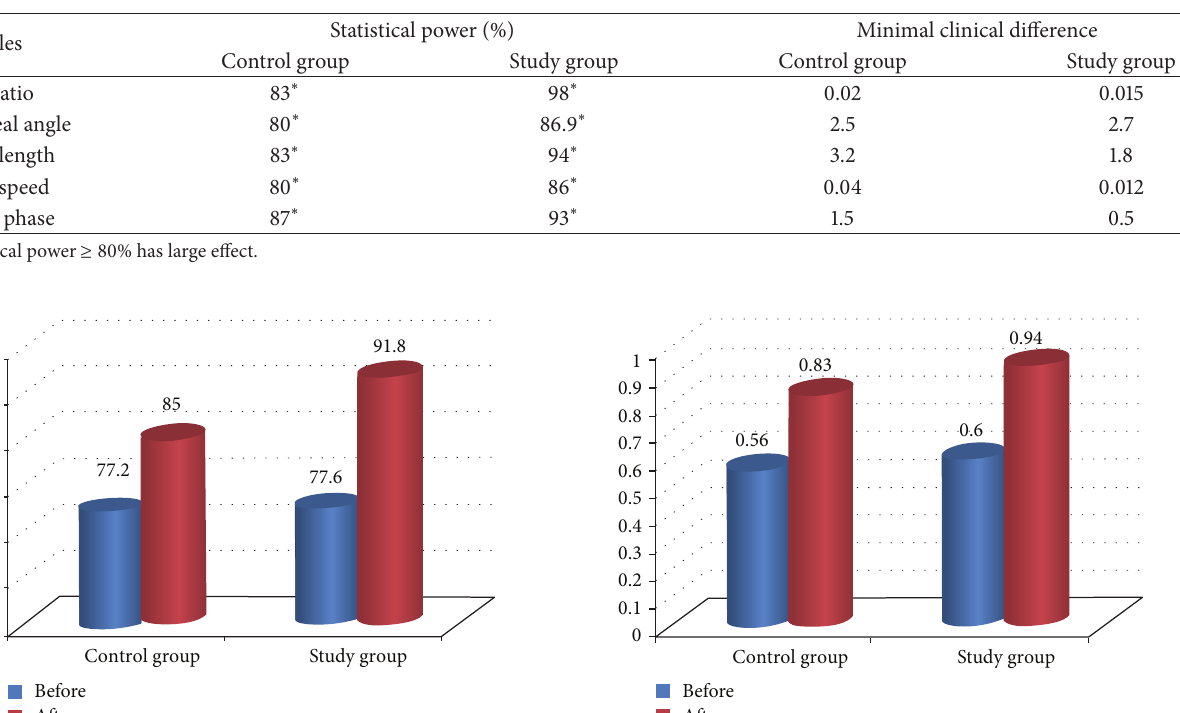
Table 5: Statistical power and minimal clinical difference for both groups.